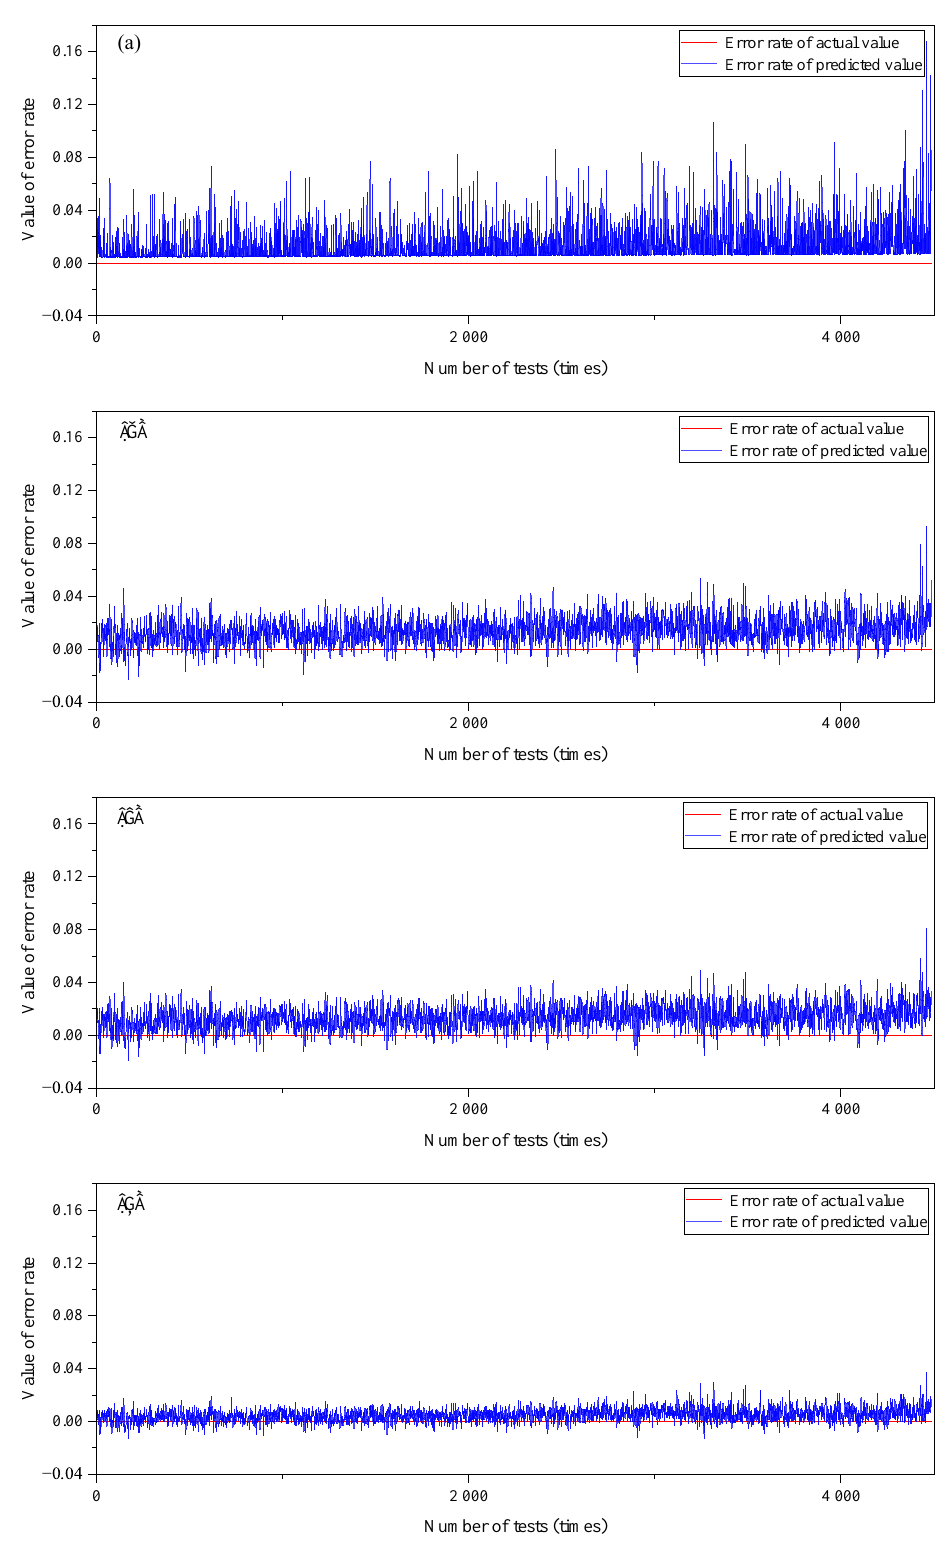
Figure 22. Comparison of model errors. ( a ) RNN, ( b ) LSTM, ( c ) GRU, ( d )